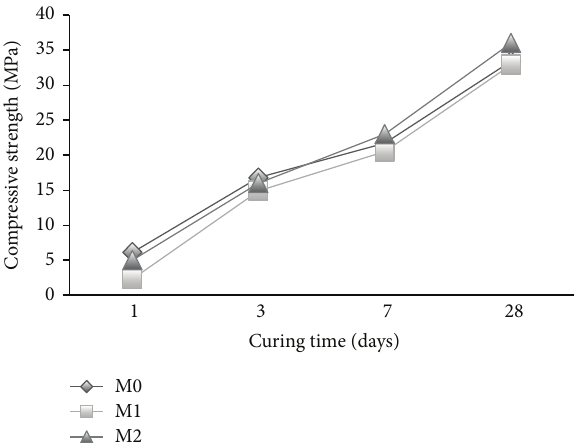
Figure 8: The effect of cosurfactants on the compressive strength of mortar.